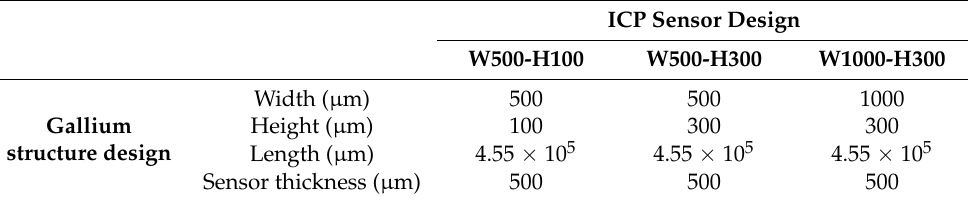
Table 1. ICP sensors with different dimensions for sensitivity